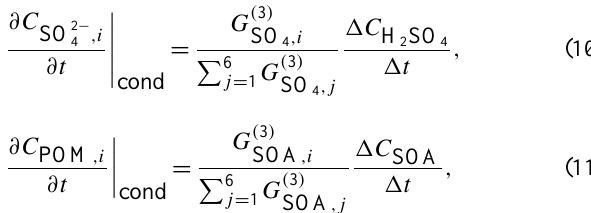
Table 2. List of the EMAC submodels that have been used in this work. Submodel Function Reference CONVECT Original ECHAM5 convection scheme Tiedtke (1989); Nordeng (1994) CVTRANS Transport of tracers by convection Tost et al. (2006b) DRYDEP Trace gas and aerosol dry deposition Kerkweg et al. (2006a) H2O Initialization of H 2 O in the stratosphere and Lelieveld et al. (2007) mesosphere from satellite observations and feedback with specific humidity JVAL Calculation of photolysis rate coefficients Landgraf and Crutzen (1998) LNOX Production of NOx by lightning Price and Rind (1992) MADE-in Aerosol microphysics this study MECCA Tropospheric and stratospheric chemistry Sander et al. (2005) OFFLEM Offline emissions Kerkweg et al. (2006b) ONLEM Online emissions Kerkweg et al. (2006b) RAD4ALL Original ECHAM5 radiation model Roeckner et al. (2003) SCAV Wet deposition and liquid phase chemistry Tost et al. (2006a, 2007) SEDI Sedimentation of aerosols Kerkweg et al. (2006a) TNUDGE Nudging of tracers Kerkweg et al. (2006b) TROPOP Calculation of the altitude of the tropopause J¨ockel et al. (2006) CLOUD Cloud physics Lohmann (2002), Lohmann and K¨archer